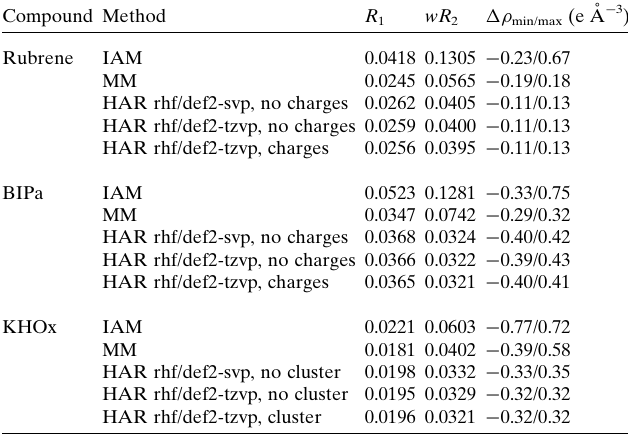
Table 3 Refinement results of the IAMs, MMs and HARs of rubrene, BIPa and KHOx. All values refer to the full resolutions of the data sets and the observed reflections as specified in Table